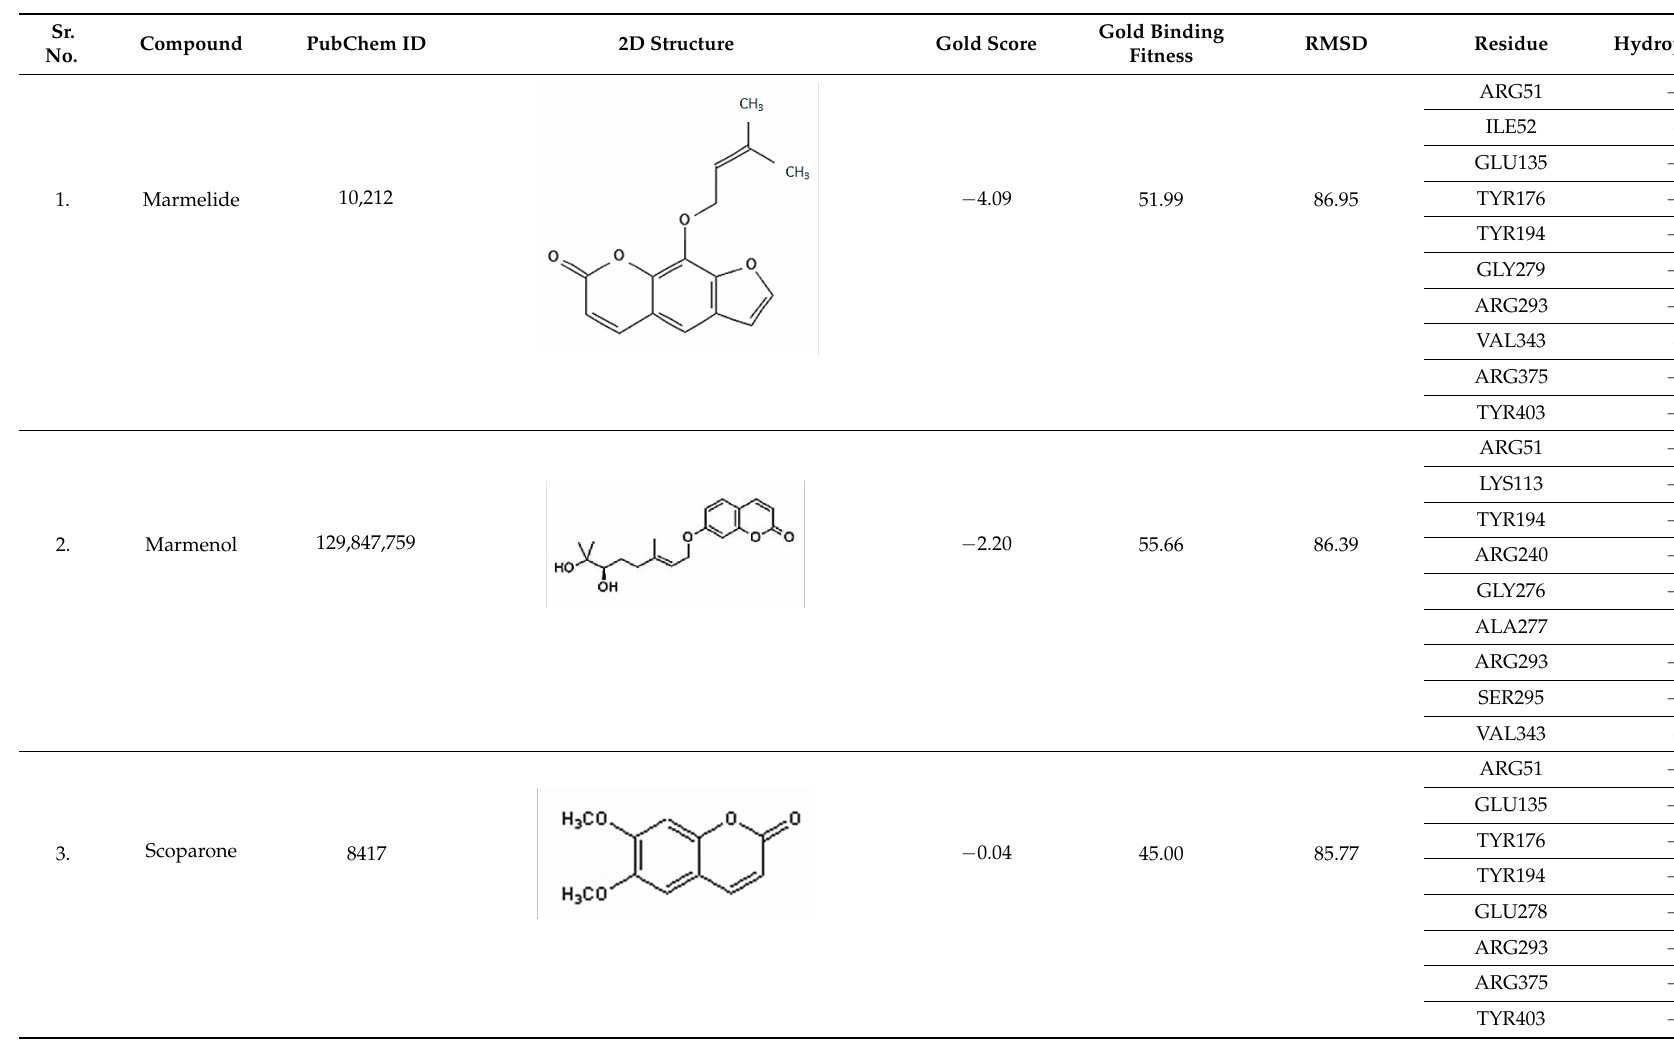
Table 7. Docking interactions of selected bioactive compounds of A.